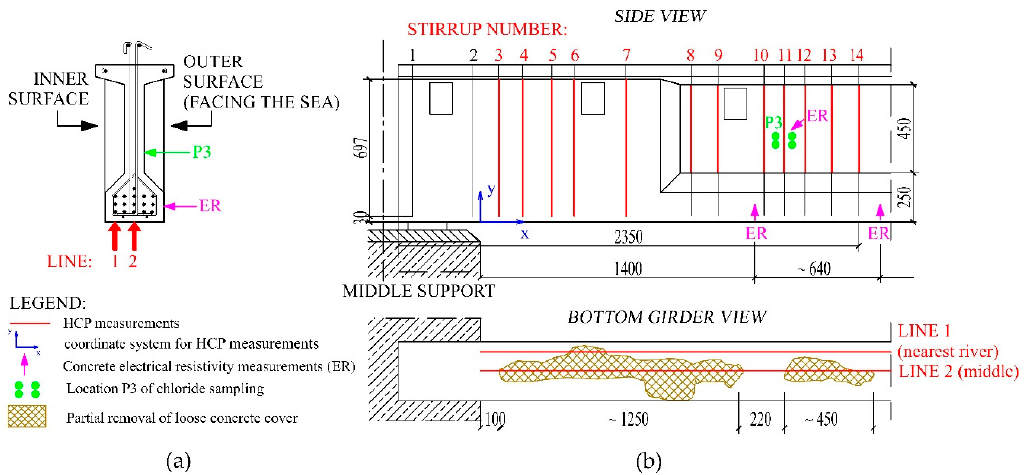
Figure 2. Location of half-cell potential (HCP) and electrical resistivity (ER) measurements in Girder 2: ( a ) measurements in the girder’s bottom flange; ( b ) measurements (mm) in the web above the stirrups, and removal of loose parts of concrete cover.